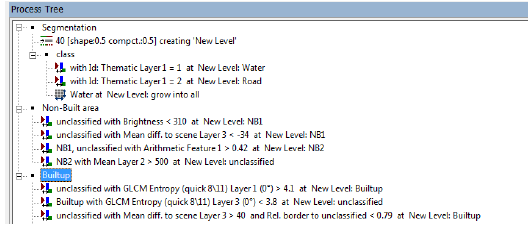
Figure 4. Rule set for classification